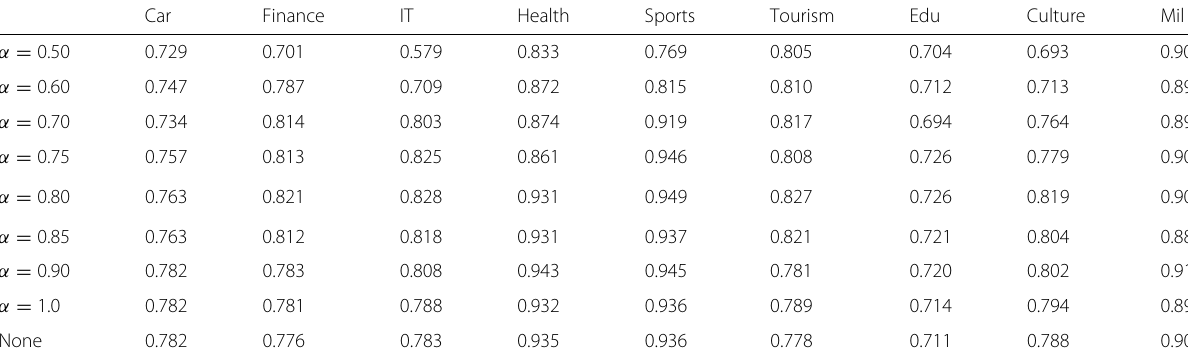
Table 1 F1 score of each category when α takes different values Car